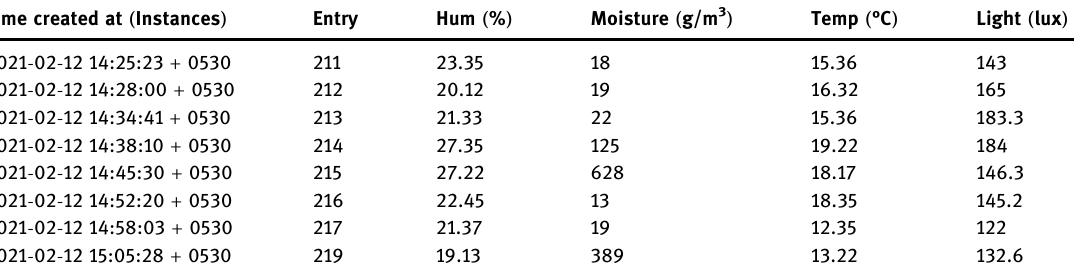
Table 5: Collected entries of sensed data Time created at ( Instances )